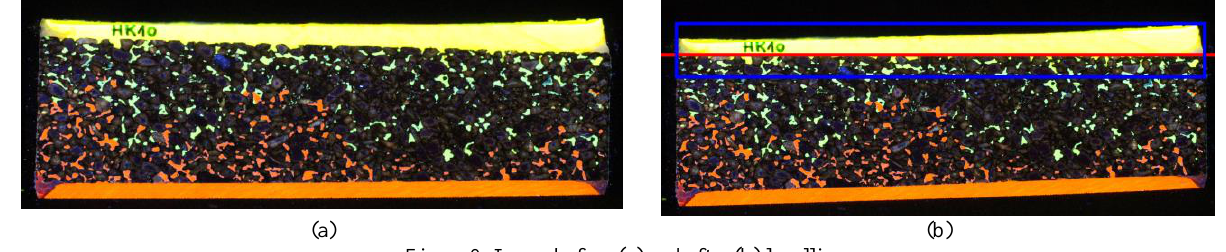
Figure 9: Image before (a) and after (b)